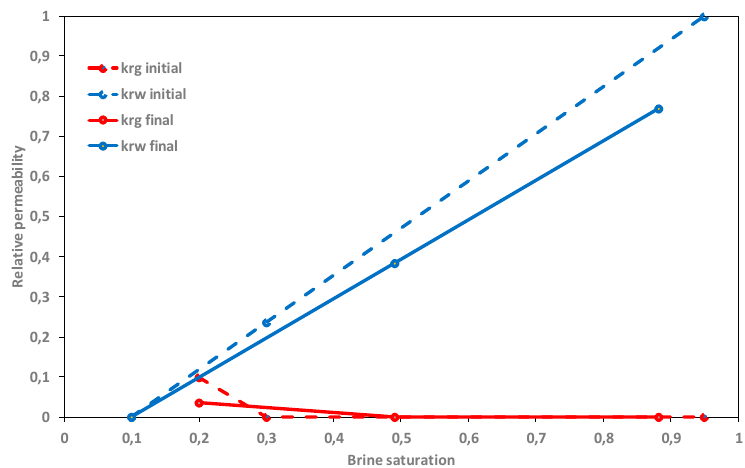
Figure 12. The change of CO 2 and brine relative permeability in the fractures during the history matching.